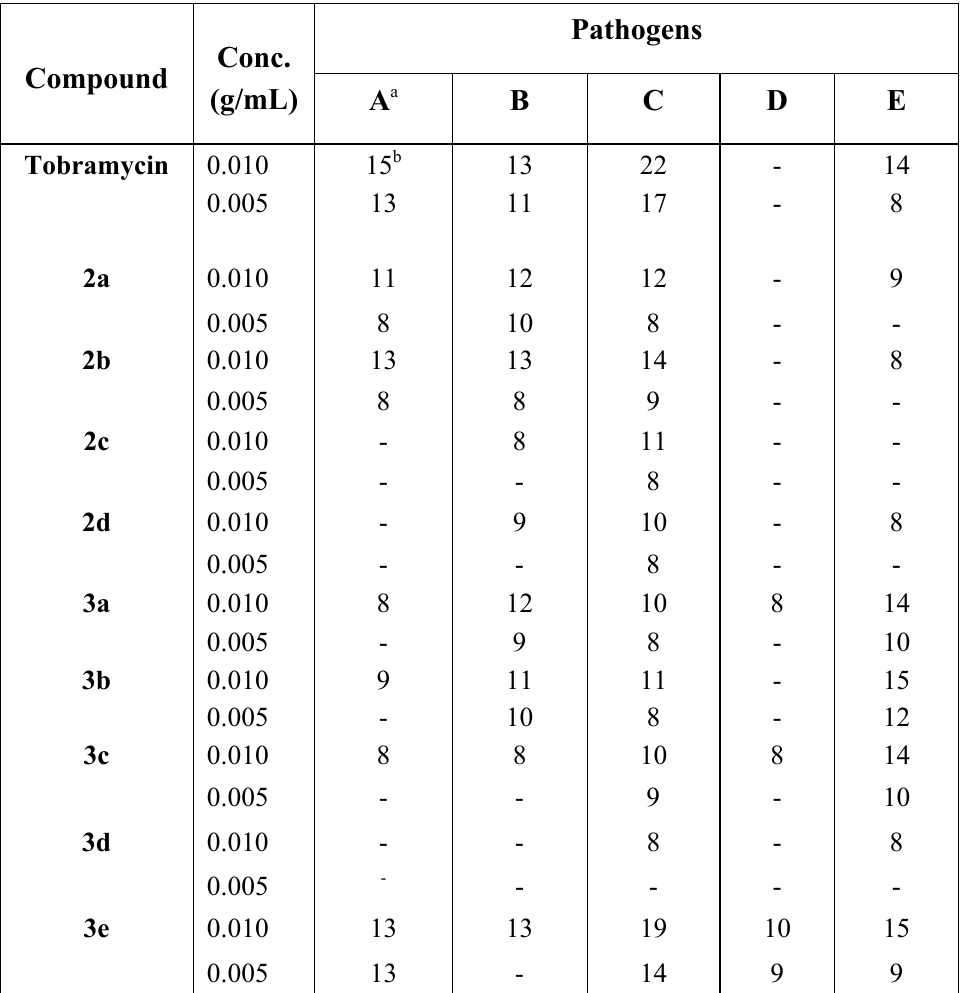
Table 1. Sensitivity of human pathogenic microbes to the new synthetic heterocyclic compounds using the hole